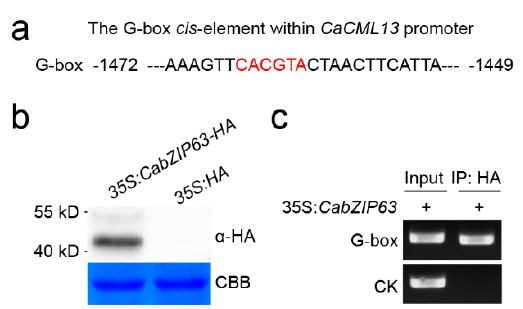
Figure 6. Enrichments of CabZIP63 on the promoter of CaCML13 by ChIP-PCR. ( a ) G-box-containing promoter of CaCML13 from − 1472 to − 1449 bp; ( b ) success of CabZIP63-HA expression in pepper leaves infiltrated with A. tumefaciens GV30101 cells containing 35S:CabZIP63-HA by western blotting using antibodies of HA; ( c ) enrichments of CabZIP63 on G-box within CaCML13 promoter by ChIP-PCR. CK that used as a negative control represents the G-box-free DNA fragment within CaCML13 promoter. The specific primer pairs used to amplify the G-box or CK were listed in Table S1.